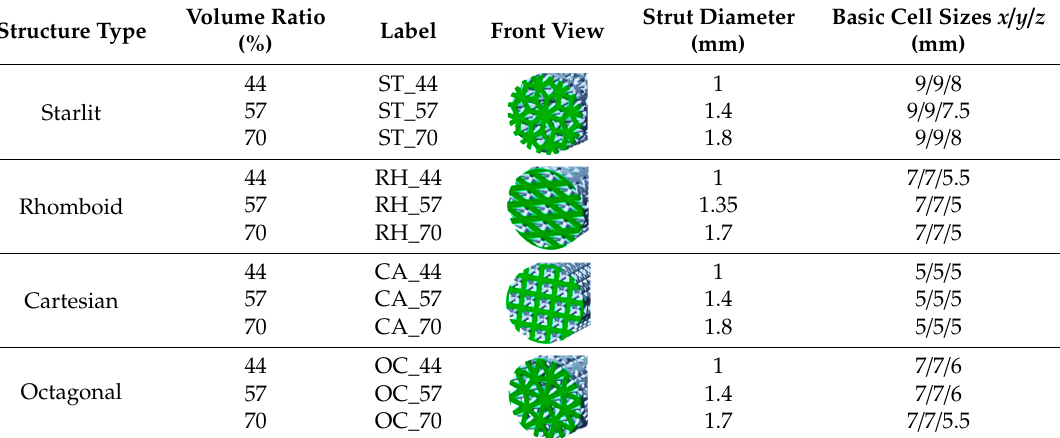
Table 1. Characteristics of the investigated 3D-printed structures.